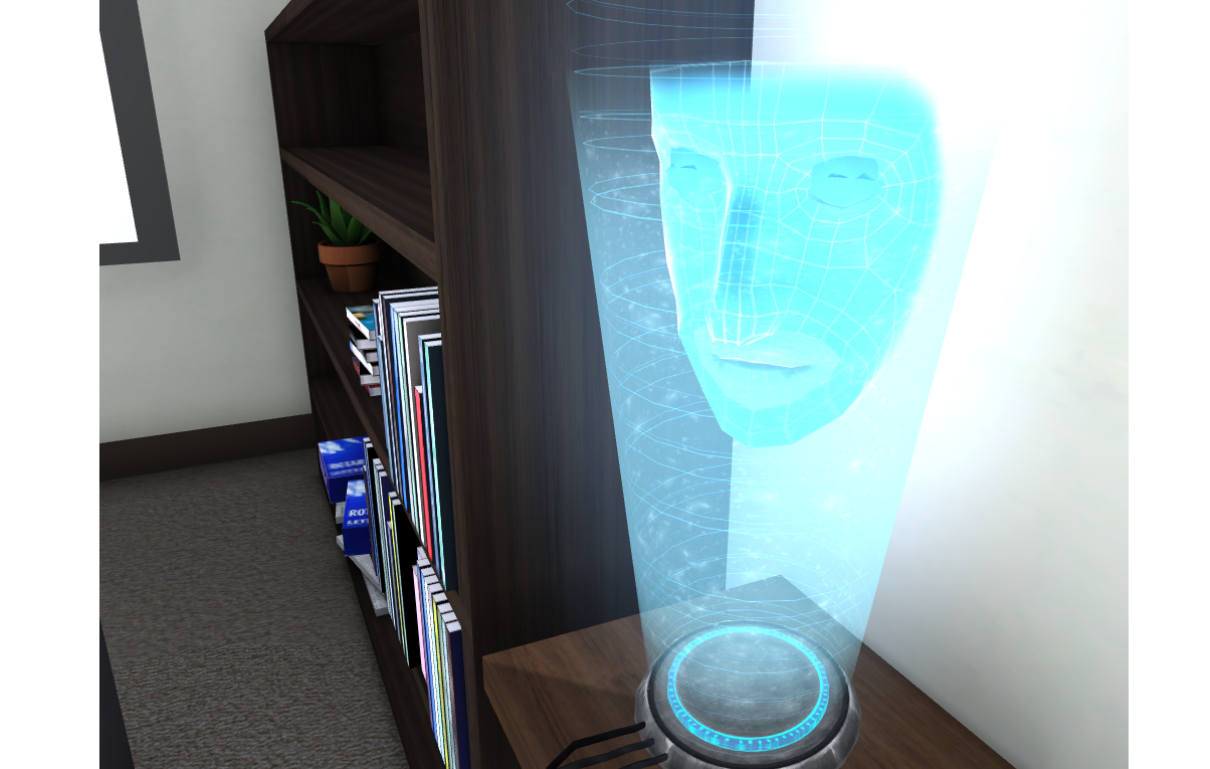
Figure 1. Physical embodiment of the primarily voice-based virtual